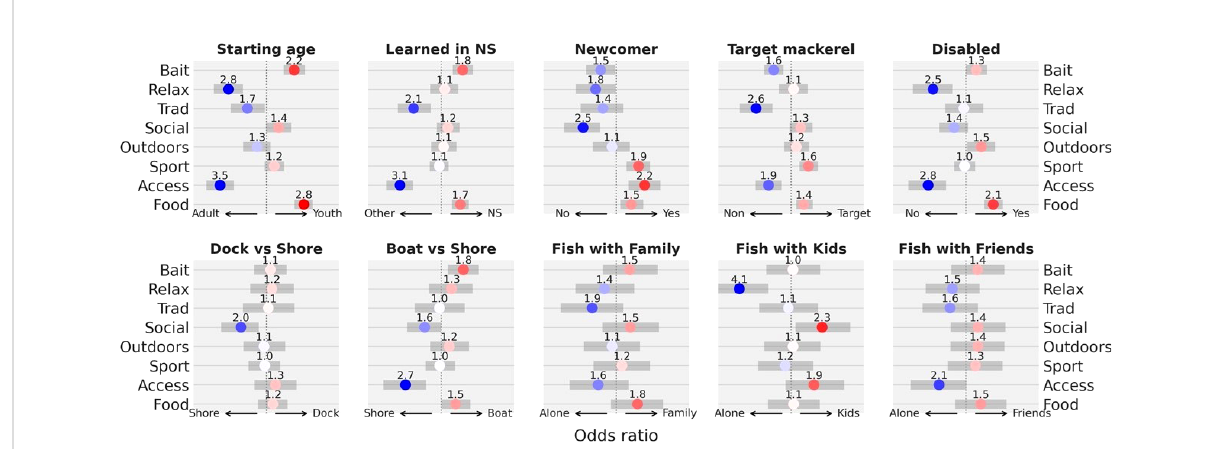
FIGURE 3 Odds ratio plots for reasons anglers fi sh for Atlantic mackerel or Amalamaq ( Scomber scombrus ) in Nova Scotia/Mi ’ kma ’ ki for recreational purposes as a function of selected key covariates. Points are highest posterior density (HPD) odds ratios for conditions listed at the bottom of each panel, with grey bars representing 50% HPD intervals. Grey bars not spanning unity (vertical 1:1) are considered to have clear evidence of differences between groups. Colours shaded for magnitude of the odds ratio for conditions on the left (blue) and right